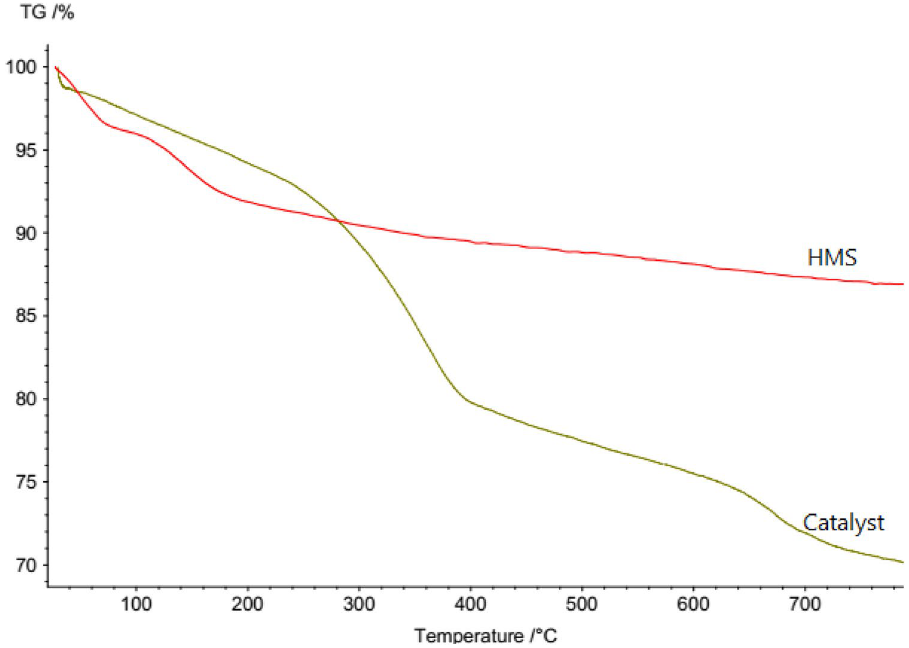
Figure 12. Thermogravimetric curves of HMS and HMS/Pr-PTSC-Cu.